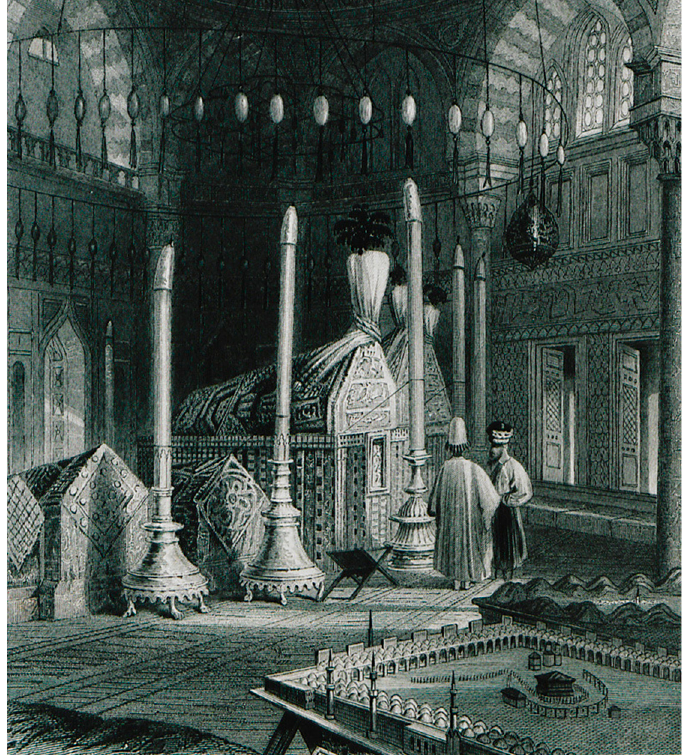
Figure 15. Scale models of Mecca (foreground) and Medina (visible just behind and to the right of the Mecca model) within the türbe of Sultan Süleym¯an, as depicted in the 1830s. From Julia Pardoe, The Constantinople and its Environs, from original Drawings by W.H. Bartlett (London: George Virtue,